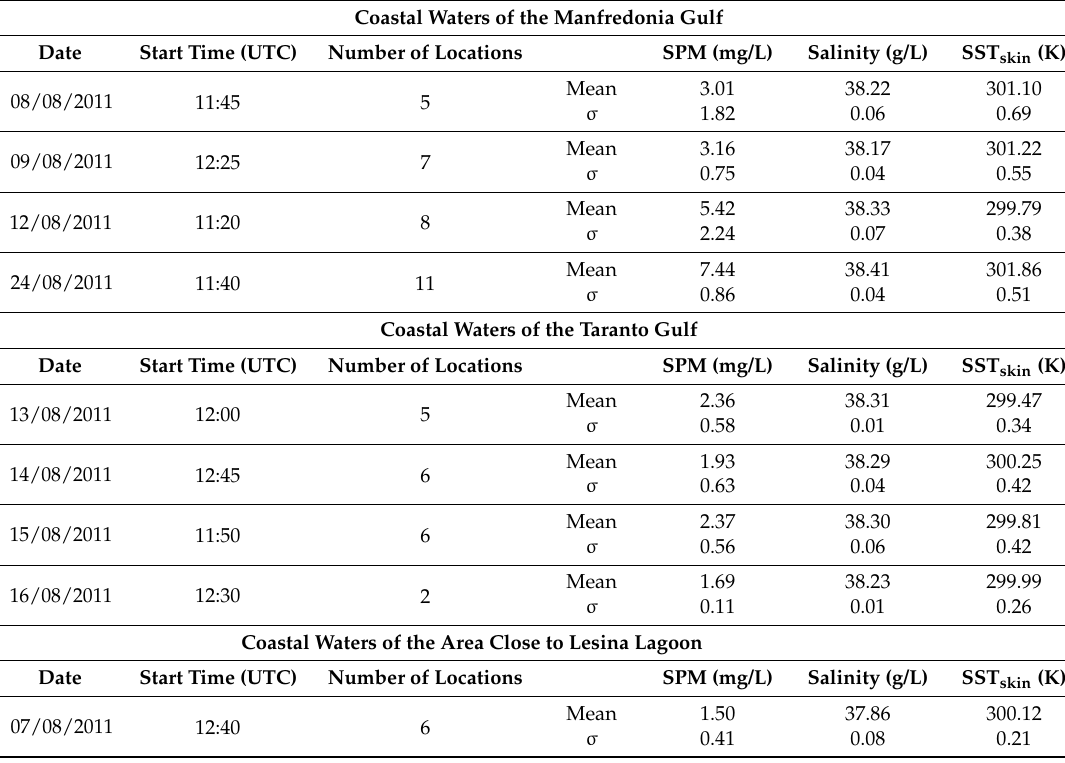
Table 1. Date and start time of the moderate resolution imaging spectroradiometer (MODIS) overpasses, number of observations monitored within ± 2 h with respect to MODIS overpasses, means, and standard deviations ( σ ) of SPM and salinity concentrations, and SST skin